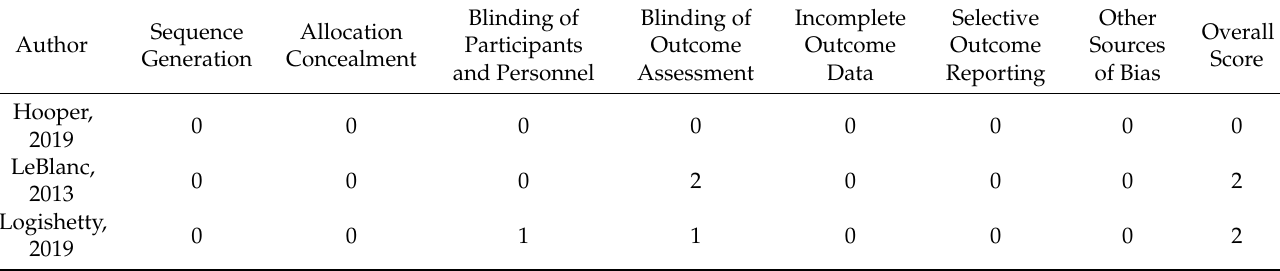
Table 1. Cochrane Risk of Bias Tool for assessing the risk of bias in randomized